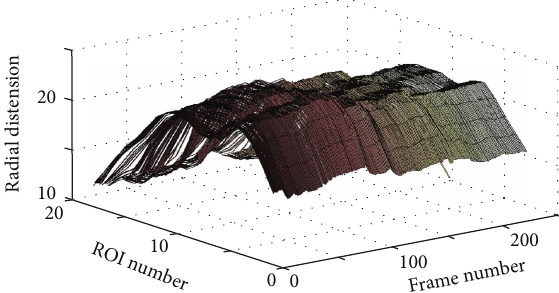
Figure 12: 3D plot showing the wave propagation along the vessel wall for the elderly case E1.